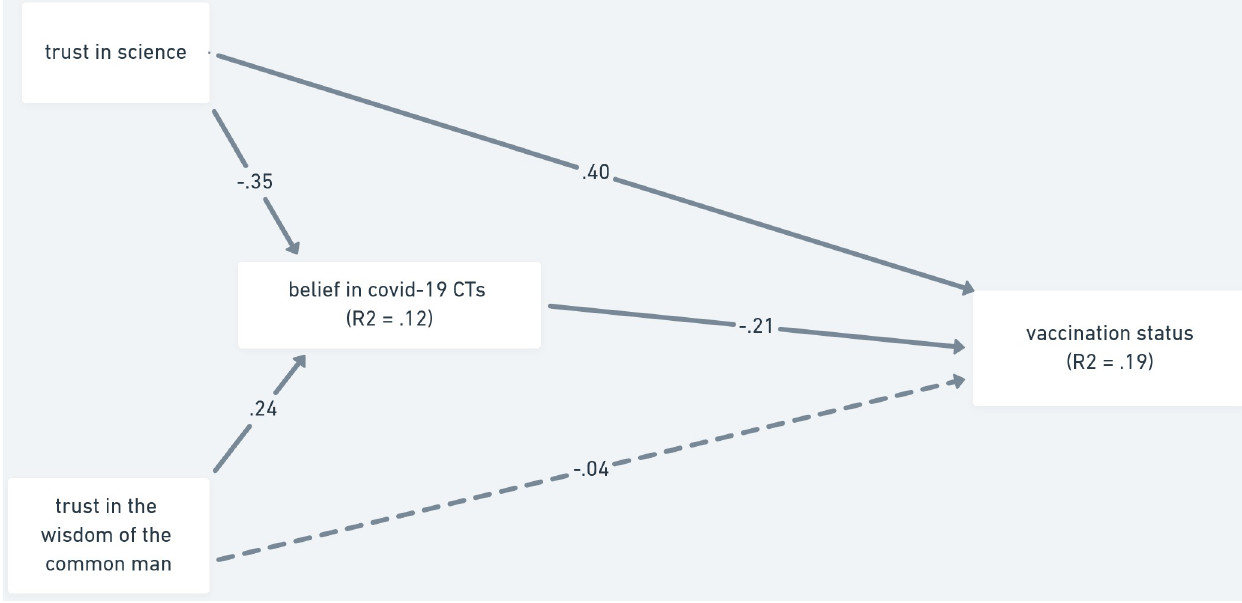
Fig 1. Mediation analysis of trust as a predictor of vaccination status via belief in COVID-19 conspiracy theories—Study 1. Note . The paths are shown with standardized estimates. Non-significant paths are shown with dashed lines.